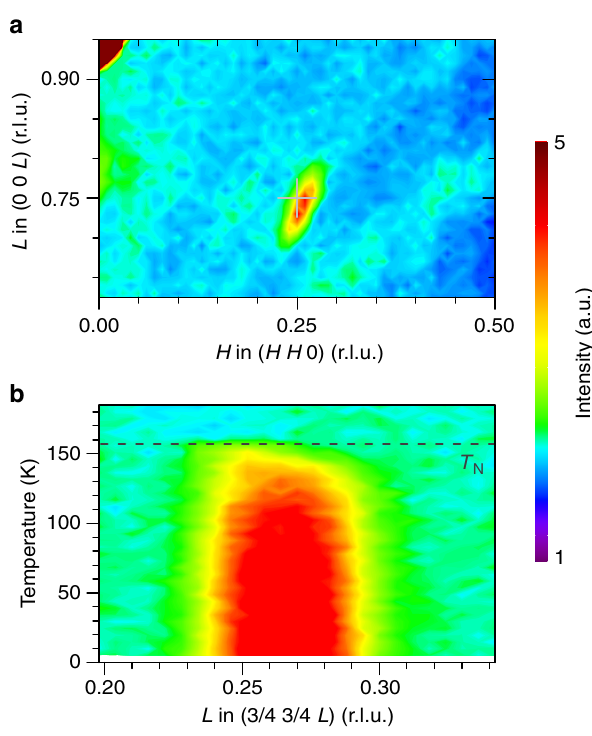
Fig. 3 Single crystal neutron-diffraction measurements. a Neutron scattering intensities within the ( H H L ) plane of reciprocal space (in pseudocubic notation) of the LaNiO 3 single crystal. These intensites were obtained at 1.6 K. b The temperature dependence of a quarter-integer peak as measured in (3/4 3/4 L ) scans for different temperatures. The dashed line indicates the transition temperature ( T N ) observed in the speci fi c heat